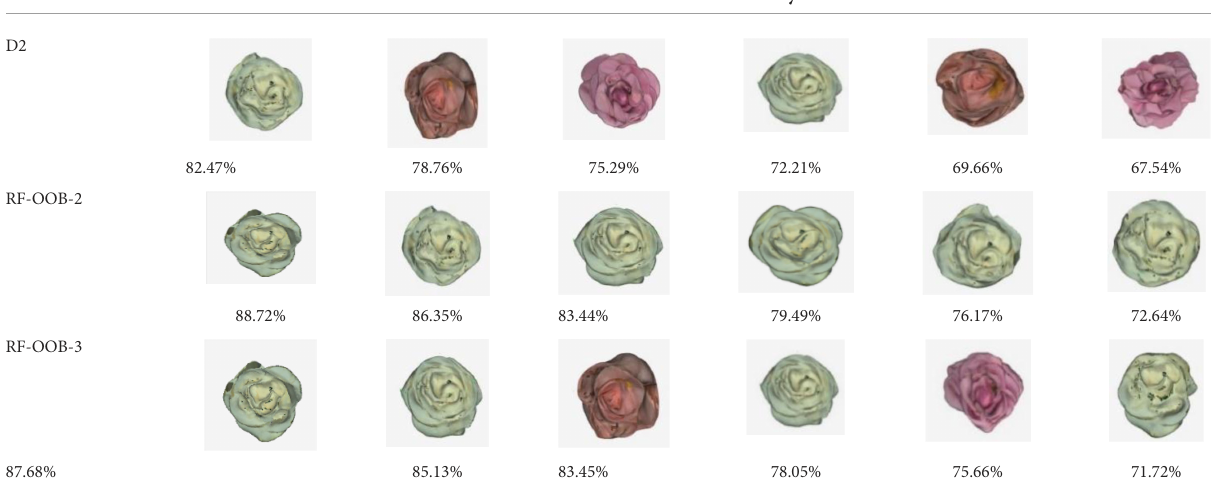
TABLE 5 Retrieval results of 3D models of Swan antique rose fl owers. Method